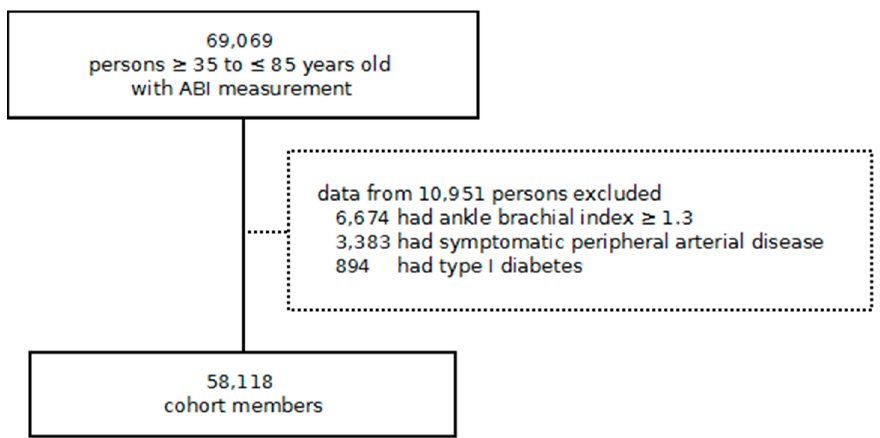
Figure 1. Study flowchart. ABI indicates ankle–brachial index.